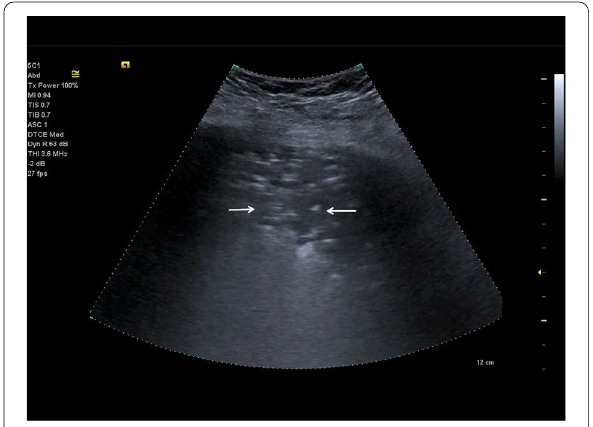
Fig. 5 Lung ultrasonography using a linear probe. Discontinuous pleura (white arrows) with tiny round hypoechoic